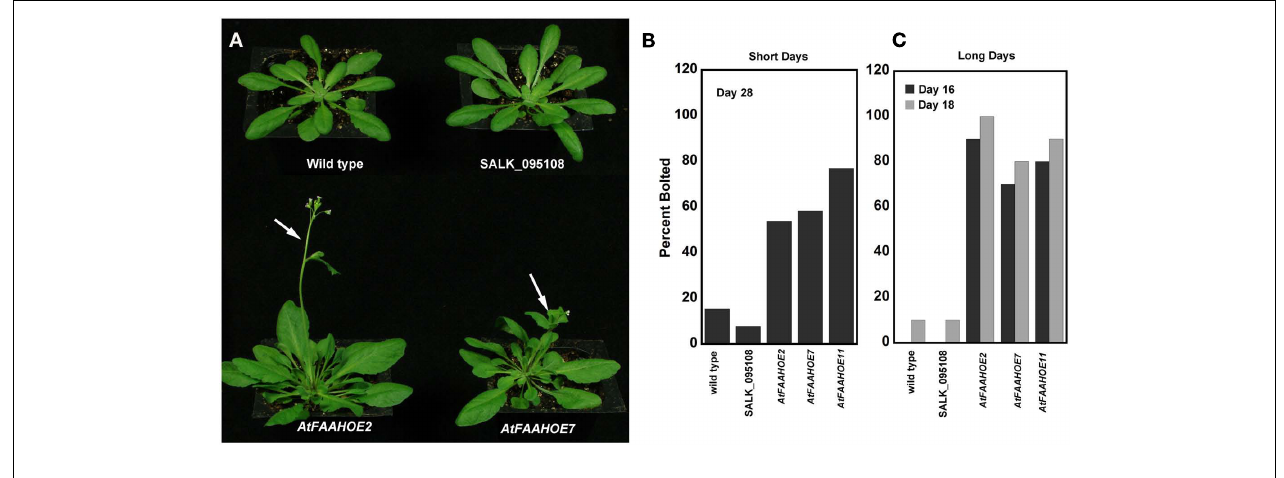
overexpressors have already flowered (arrows).The percent of wild type, AtFAAH knockout and AtFAAH overexpressors that had flowered by day 28 under non-inductive SDs (B) and by day 16 and day 18 under inductive LDs (C) .The graph is representative of three experiments with n >